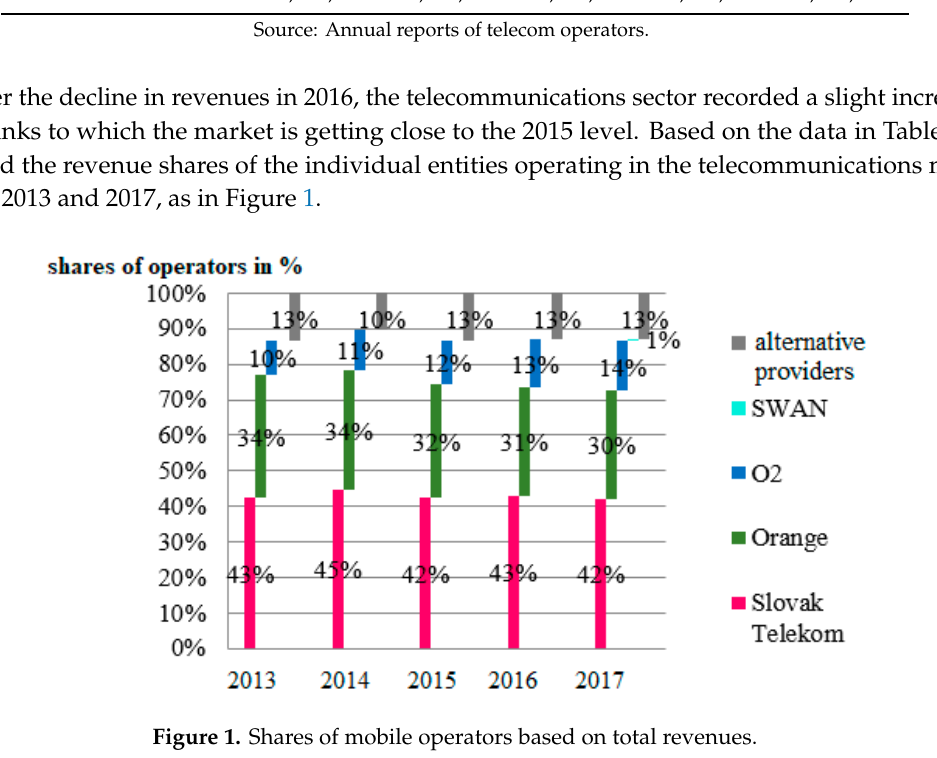
Figure 1. Shares of mobile operators based on total revenues.